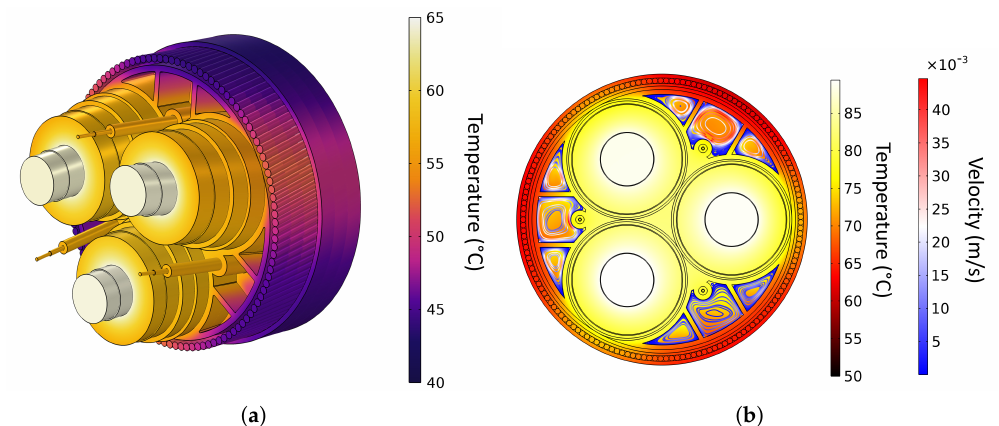
Figure 5. ( a ) 3D temperature distribution; ( b ) temperature and air velocity fields in the 2D geometry.